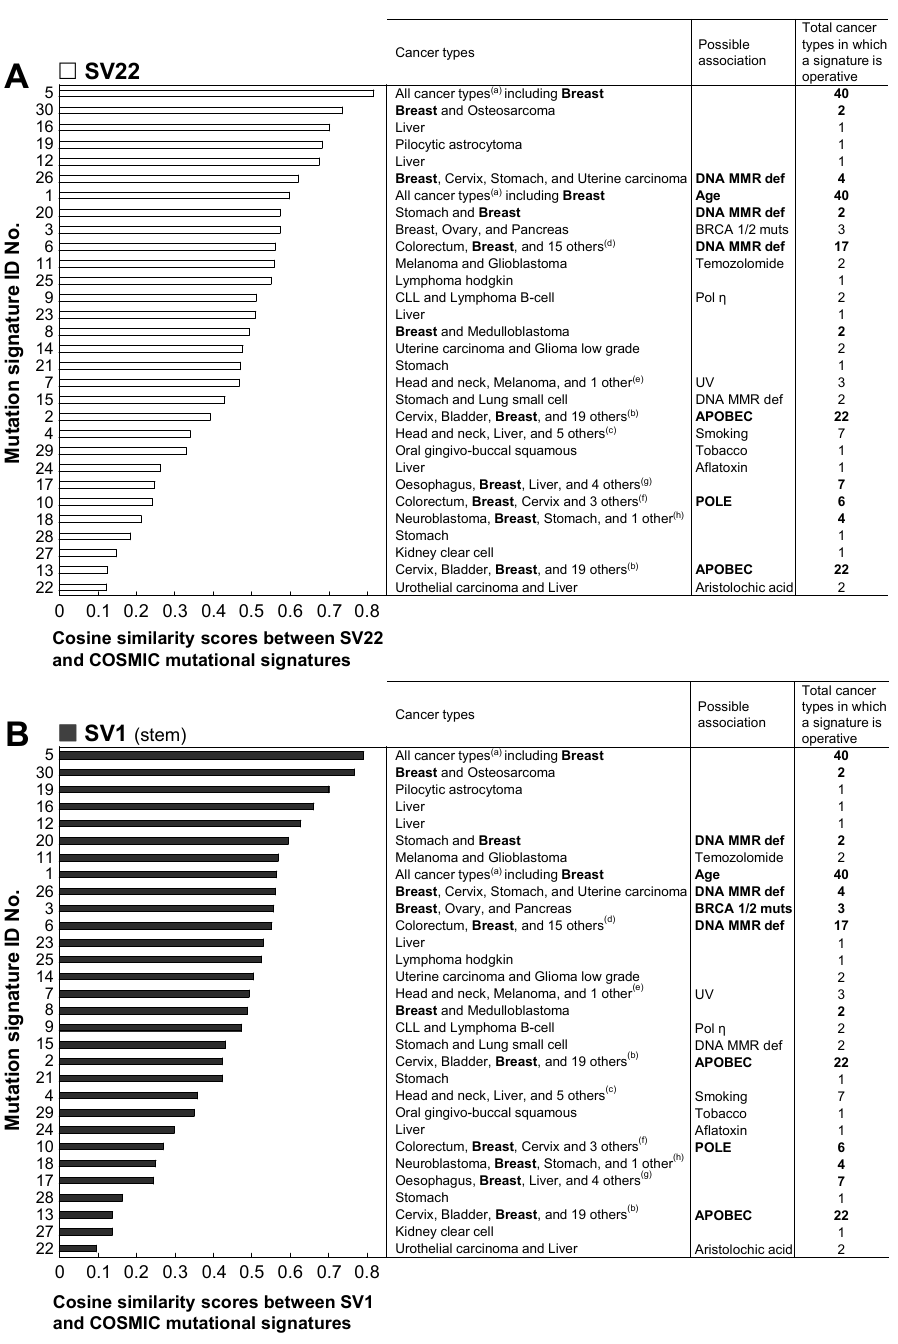
Figure 3. Correlation between the mutation context spectra of the mtDNA rare unique mutations in SV22 (immortalized non-stem) ( A ) and SV1 (immortalized stem) ( B ) cells vs. the 30 published